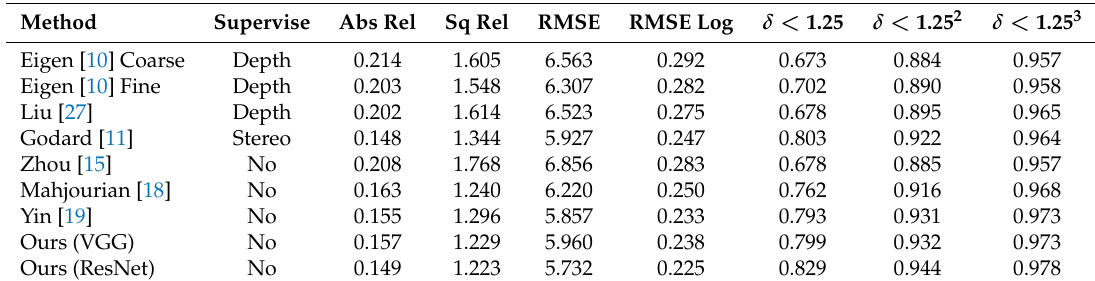
Table 1. Monocular depth results on KITTI by the split of Eigen et al. [10] capped 80 m. Results of other methods are taken from [15,18,19].